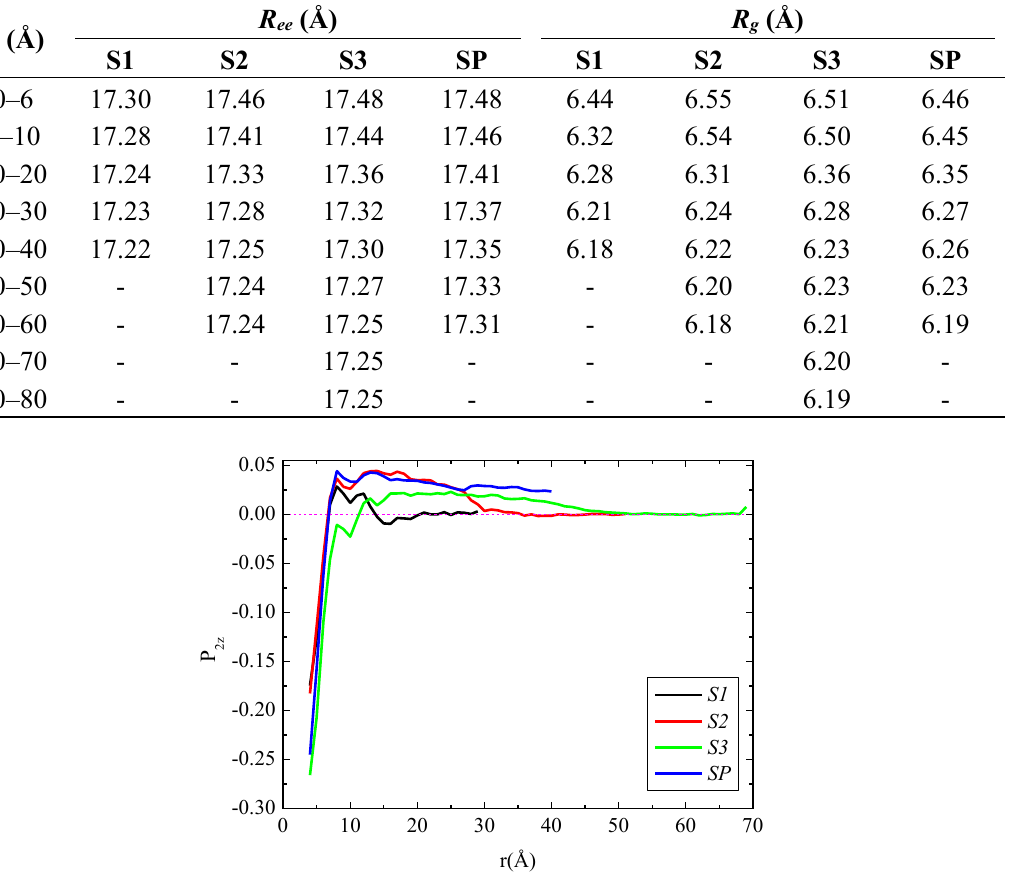
Table 2. Average chain end-to-end distance, for chains belonging in different adsorption layers, R . Corresponding bulk values: R ee = 17.20 Å, R g = 6.15 Å. Error bars are 3%–5% of the actual values based on block